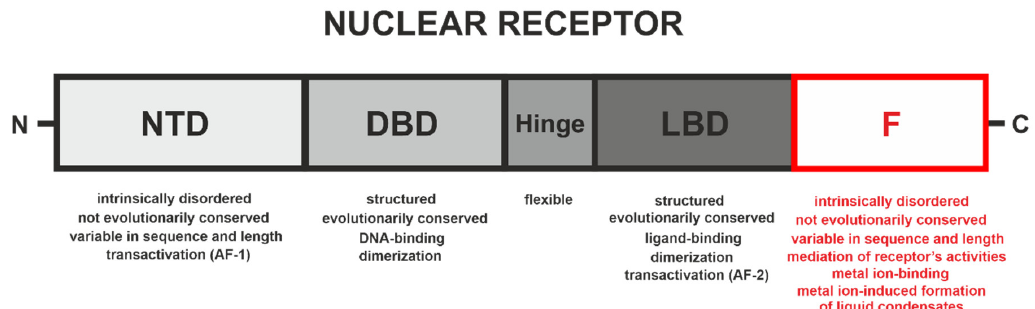
Figure 1. Scheme of the overall structural and functional organization of nuclear receptors (NRs). Nuclear receptors contain at least four distinct domains: a N-terminal domain (NTD), a DNA-binding domain (DBD), a hinge region, and a ligand-binding domain (LBD). Some NRs possess an additional C-terminal F domain. The contribution of each domain to the NR’s activities is different. The most important functions and properties located in the individual domains are listed below the scheme [1]. The F domain is marked in red [10,11].